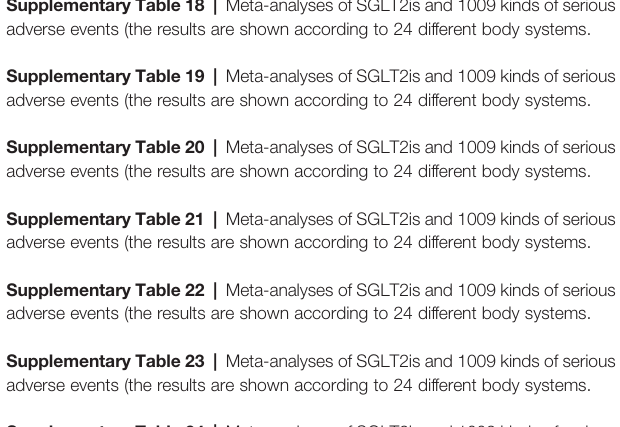
Supplementary Table 9 | Meta-analyses of SGLT2is and 1009 kinds of serious adverse events (the results are shown according to 24 different body systems. Supplementary Table 10 | Meta-analyses of SGLT2is and 1009 kinds of serious adverse events (the results are shown according to 24 different body systems. Supplementary Table 11 | Meta-analyses of SGLT2is and 1009 kinds of serious adverse events (the results are shown according to 24 different body systems. Supplementary Table 12 | Meta-analyses of SGLT2is and 1009 kinds of serious adverse events (the results are shown according to 24 different body systems. Supplementary Table 13 | Meta-analyses of SGLT2is and 1009 kinds of serious adverse events (the results are shown according to 24 different body systems. Supplementary Table 14 | Meta-analyses of SGLT2is and 1009 kinds of serious adverse events (the results are shown according to 24 different body systems. Supplementary Table 15 | Meta-analyses of SGLT2is and 1009 kinds of serious adverse events (the results are shown according to 24 different body systems. Supplementary Table 16 | Meta-analyses of SGLT2is and 1009 kinds of serious adverse events (the results are shown according to 24 different body systems. Supplementary Table 17 | Meta-analyses of SGLT2is and 1009 kinds of serious adverse events (the results are shown according to 24 different body systems. Supplementary Table 18 | Meta-analyses of SGLT2is and 1009 kinds of serious adverse events (the results are shown according to 24 different body systems. Supplementary Table 19 | Meta-analyses of SGLT2is and 1009 kinds of serious adverse events (the results are shown according to 24 different body systems. Supplementary Table 20 | Meta-analyses of SGLT2is and 1009 kinds of serious adverse events (the results are shown according to 24 different body systems. Supplementary Table 21 | Meta-analyses of SGLT2is and 1009 kinds of serious adverse events (the results are shown according to 24 different body systems. Supplementary Table 22 | Meta-analyses of SGLT2is and 1009 kinds of serious adverse events (the results are shown according to 24 different body systems. Supplementary Table 23 | Meta-analyses of SGLT2is and 1009 kinds of serious adverse events (the results are shown according to 24 different body systems. Supplementary Table 24 | Meta-analyses of SGLT2is and 1009 kinds of serious adverse events (the results are shown according to 24 different body